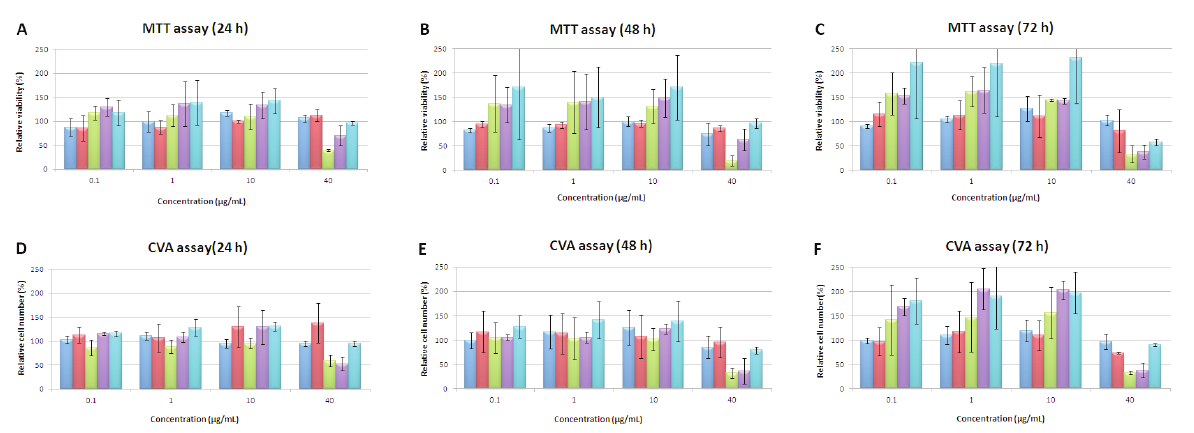
Figure 2. Effect of H. magnifica , H. crispa , H. malu , C. adhaesivum and E. quadricolor (each represented individually as bars from left to right respectively) on growth of T47D cells measured by the MTT and crystal violet assays. Data are shown as mean ± SEM of three separate experiments. Treatments significantly different from the untreated control at p < 0.05 are presented as